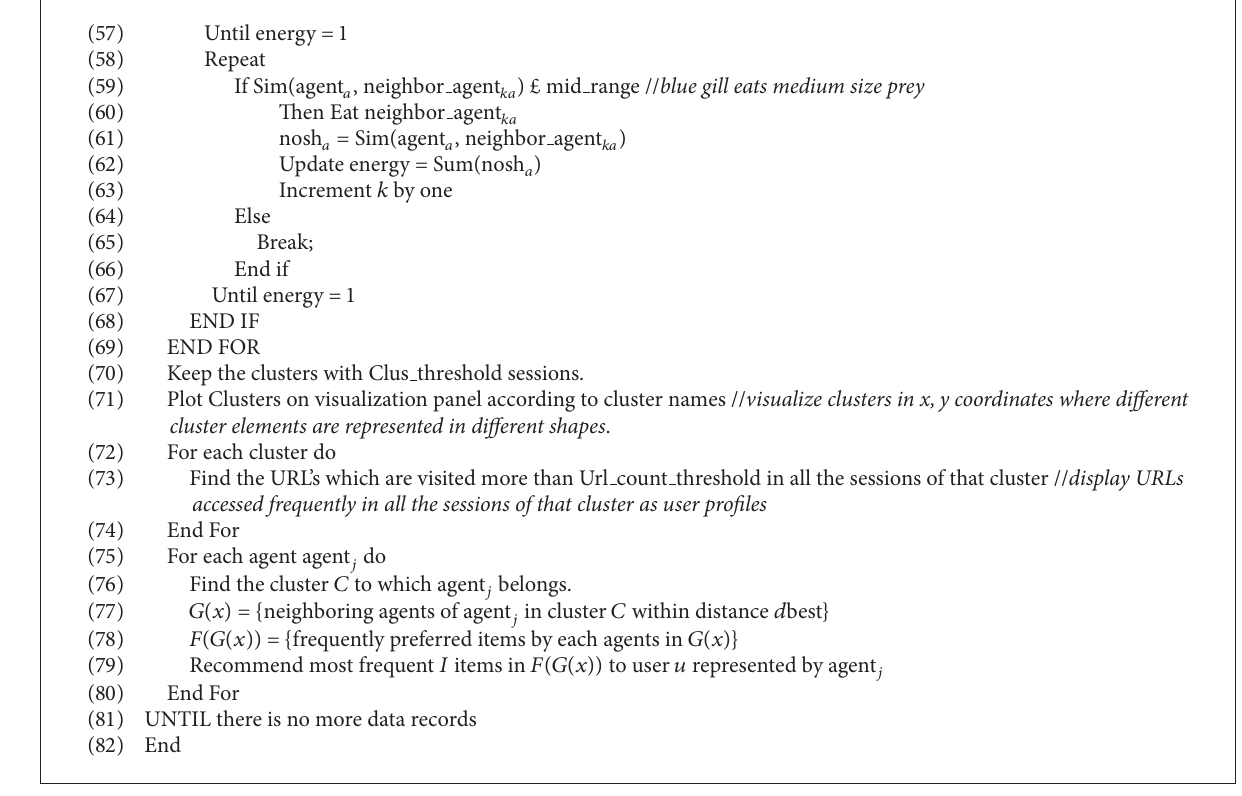
Algorithm 4: Bluegill-BestPredictions